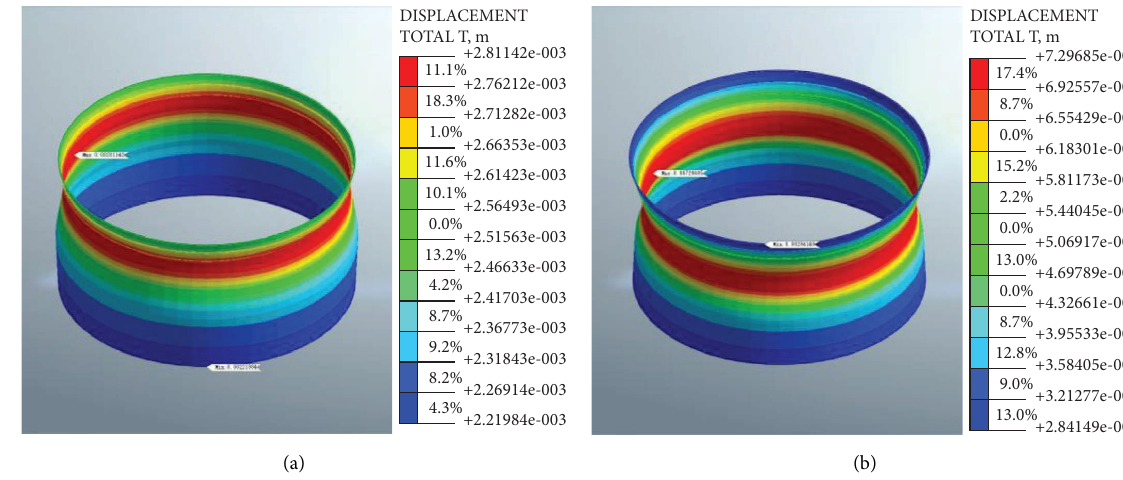
Figure 22: Working condition 4 wall deformation (a) without pore water pressure and (b) with pore water pressure